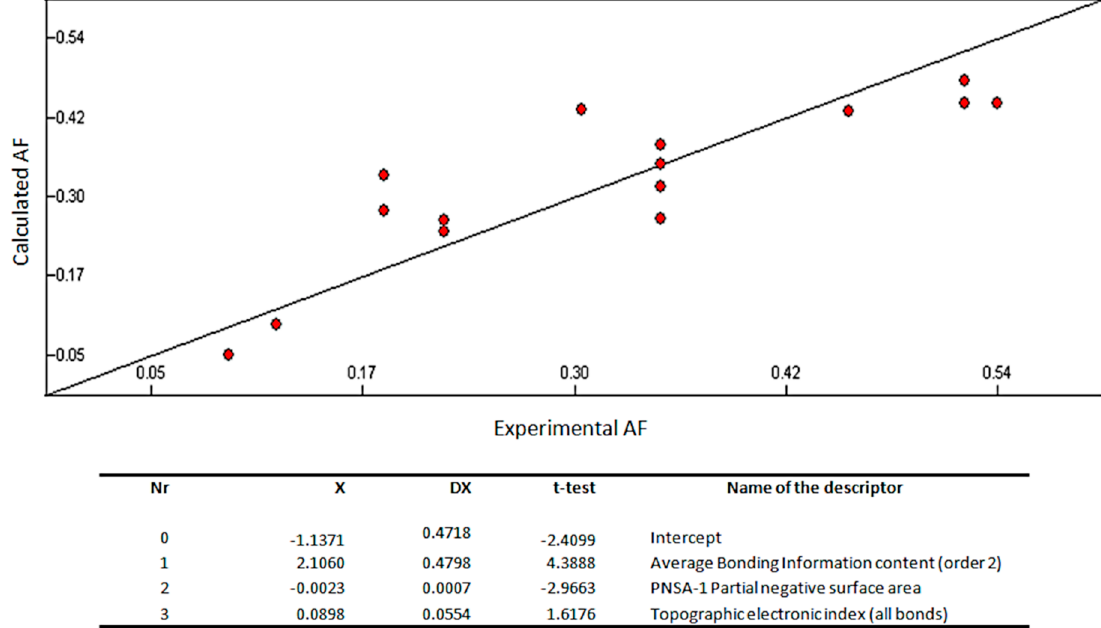
Figure 3. Quantitative structure–activity relationship (QSAR) model obtained with the heuristic method for 15 xanthones with the CODESSA software (R 2 = 0.7335, F = 10.09, and s = 0.0085). X, Δ X and t ‐ test are the regression coefficient of the linear model, standard errors of the regression coefficient, and the t significance coefficient of the determination, respectively. AF = antifouling activity.